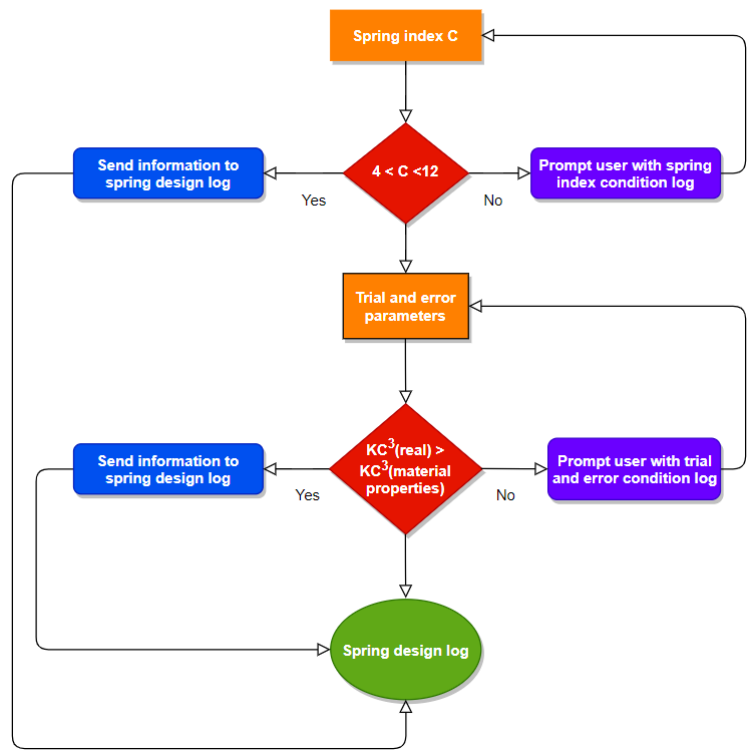
Figure 5. Condition log